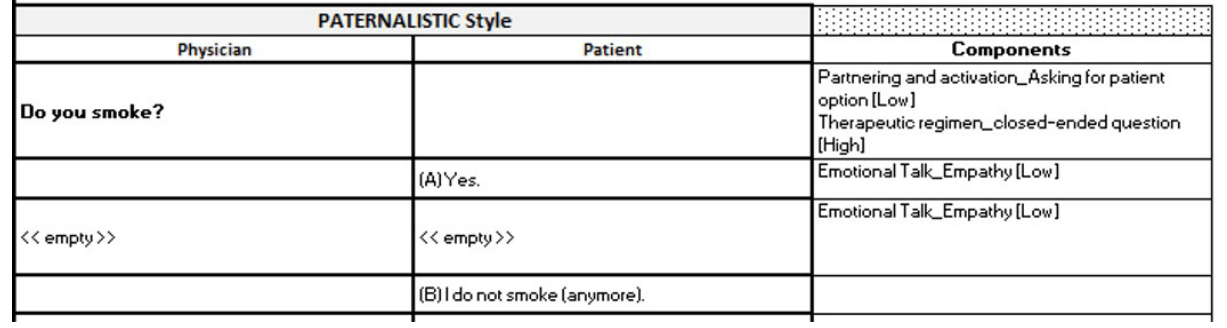
Figure 4. An example of the developed script for the paternalistic version of the conversational agent Robo is shown here. Here, the answer options for the patients, as depicted in the column “Patient,” deviated between the 2 conditions.